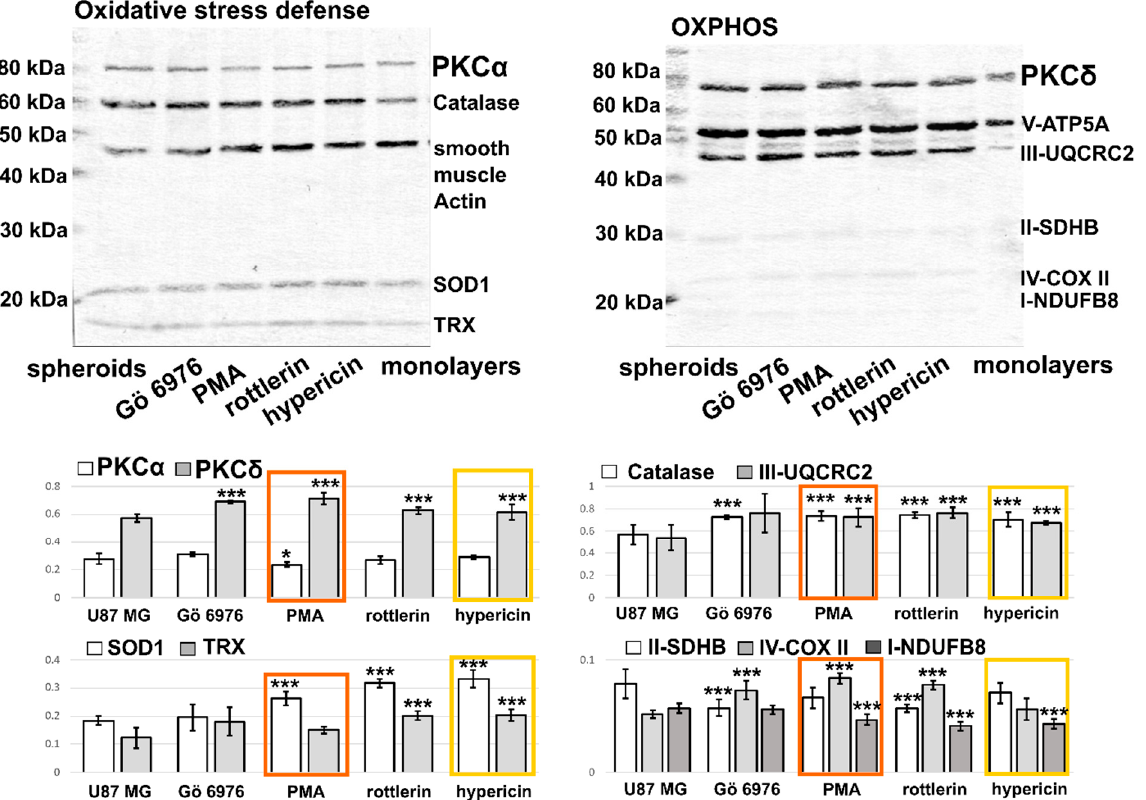
Figure 6. Western blot analysis of OXPHOS (V-ATP5A, III-UQCRC2, II-SDHB, IV-COX II, I-NDUFB8), oxidative stress defense (catalase, smooth muscle actin, SOD1, TRX), PKC α , and PKC δ levels in U87 MG spheroids grown in 10% FBS. The cells were treated with 0.5 µM Gö 6976, 0.5 µM PMA, 10 µM rottlerin, and 0.5 µM hypericin. The V-ATP5A complex can be considered as a loading control. The optical densities normalized with V-ATP5A are plotted in histograms. * p < 0.05 and *** p < 0.001.